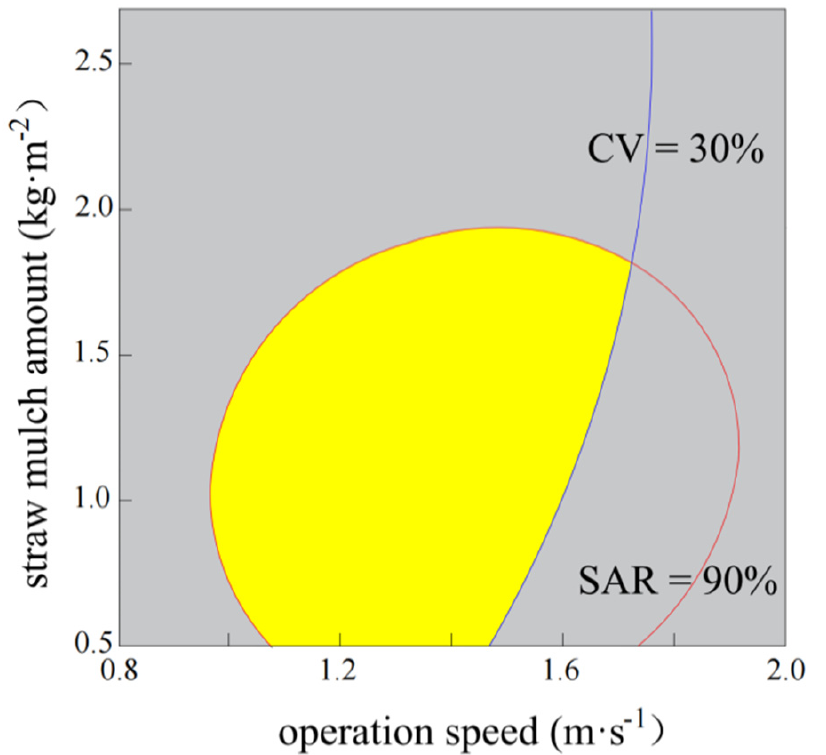
Figure 13. Parameter Optimization Analysis Chart. Note: SAR and CV are the stubble avoidance rate and coefficient of variation, respectively, %.